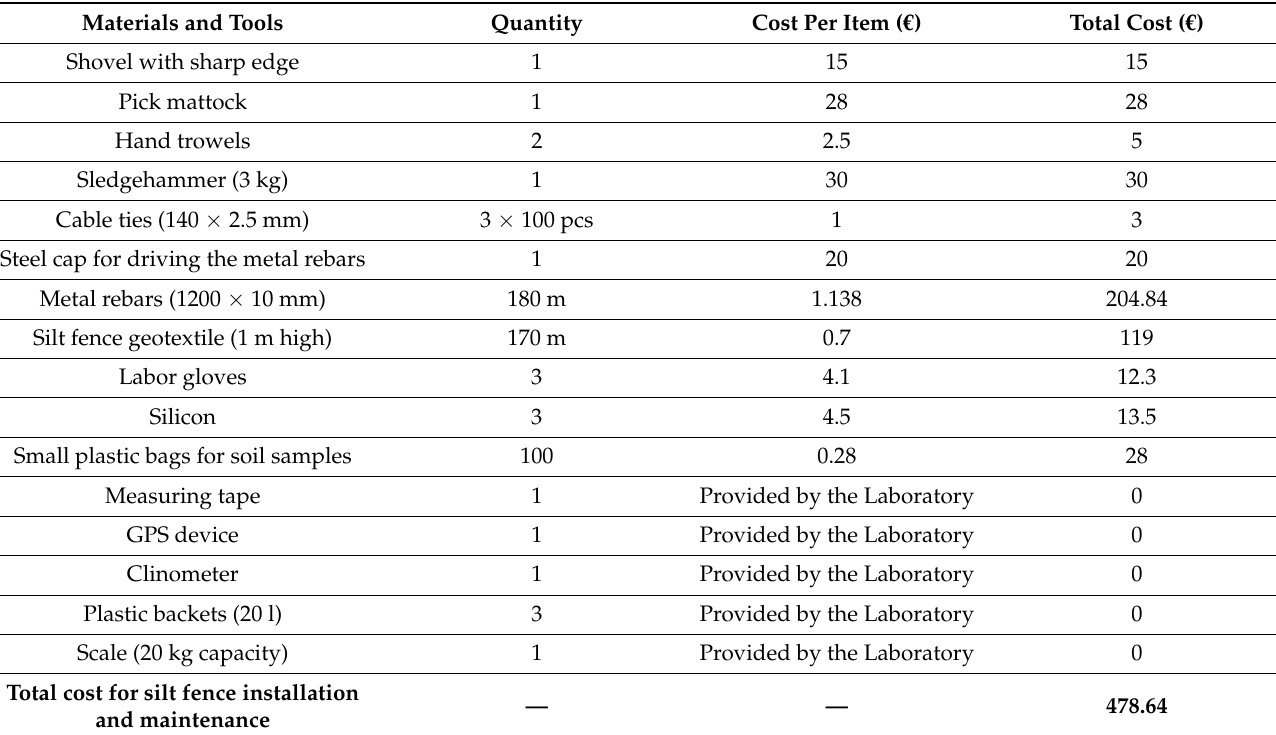
Table 1. Materials and tools that are necessary to install the silt fences and the respective cost of each item (based on the Greek market). The purchase of the materials and tools was undertaken in the year